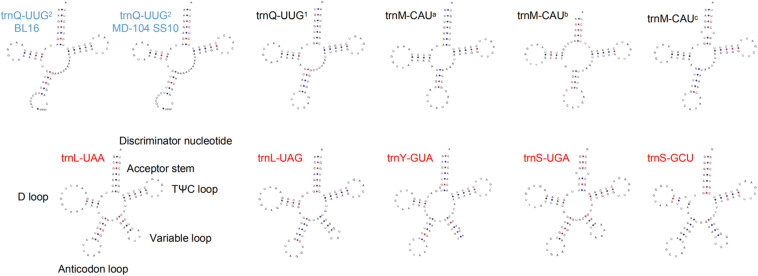
Some tRNA putative secondary structures of Wolfiporia cocos. Five tRNAs (trnS-GCU, trnL-UAA, trnY-GUA, trnS-UGA, and trnL-UAG) with red letters represent tRNAs with a variable loop. Two tRNAs with blue letters stand for tRNAs with an intron. trnM-CAUa, trnM-CAUb, and trnM-CAUc stand for three different trnM sequences with the same anticodon; trnQ-UUG1 and trnQ-UUG2 represent two different trnQ sequences with the same anticodon.